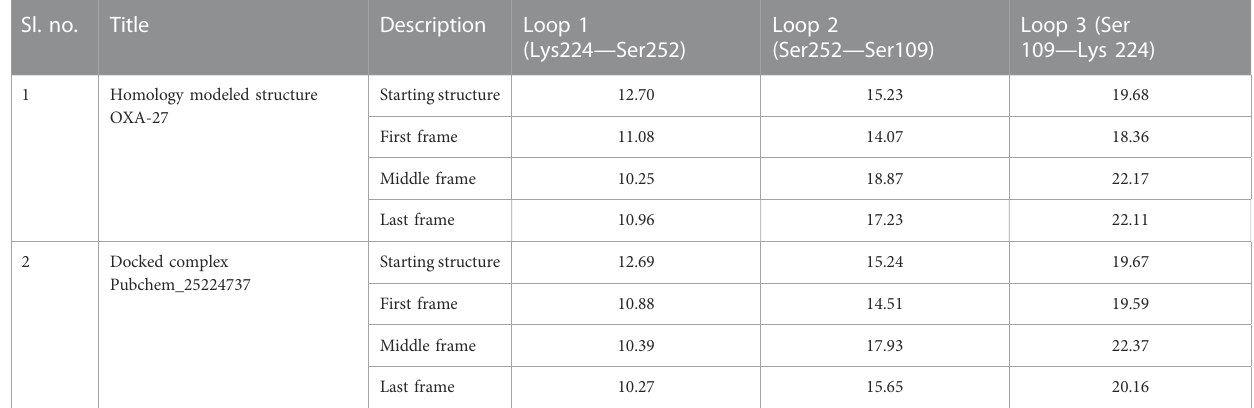
TABLE 6 Distance between starting coordinates and the fi nal coordinates during the molecular dynamics run. Sl.